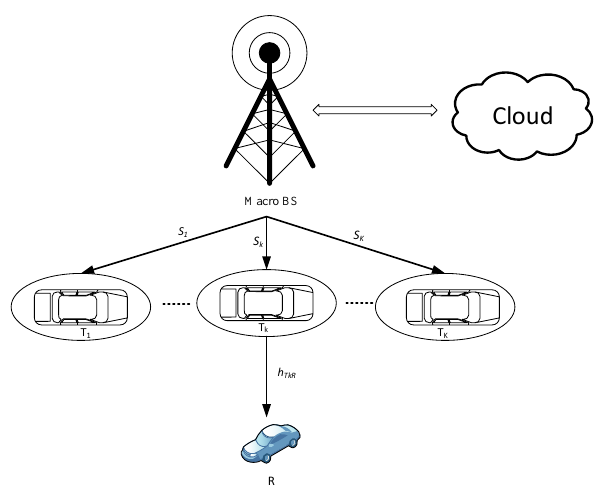
Figure 1. Vehicular network system model with mobile small cells and unreliable